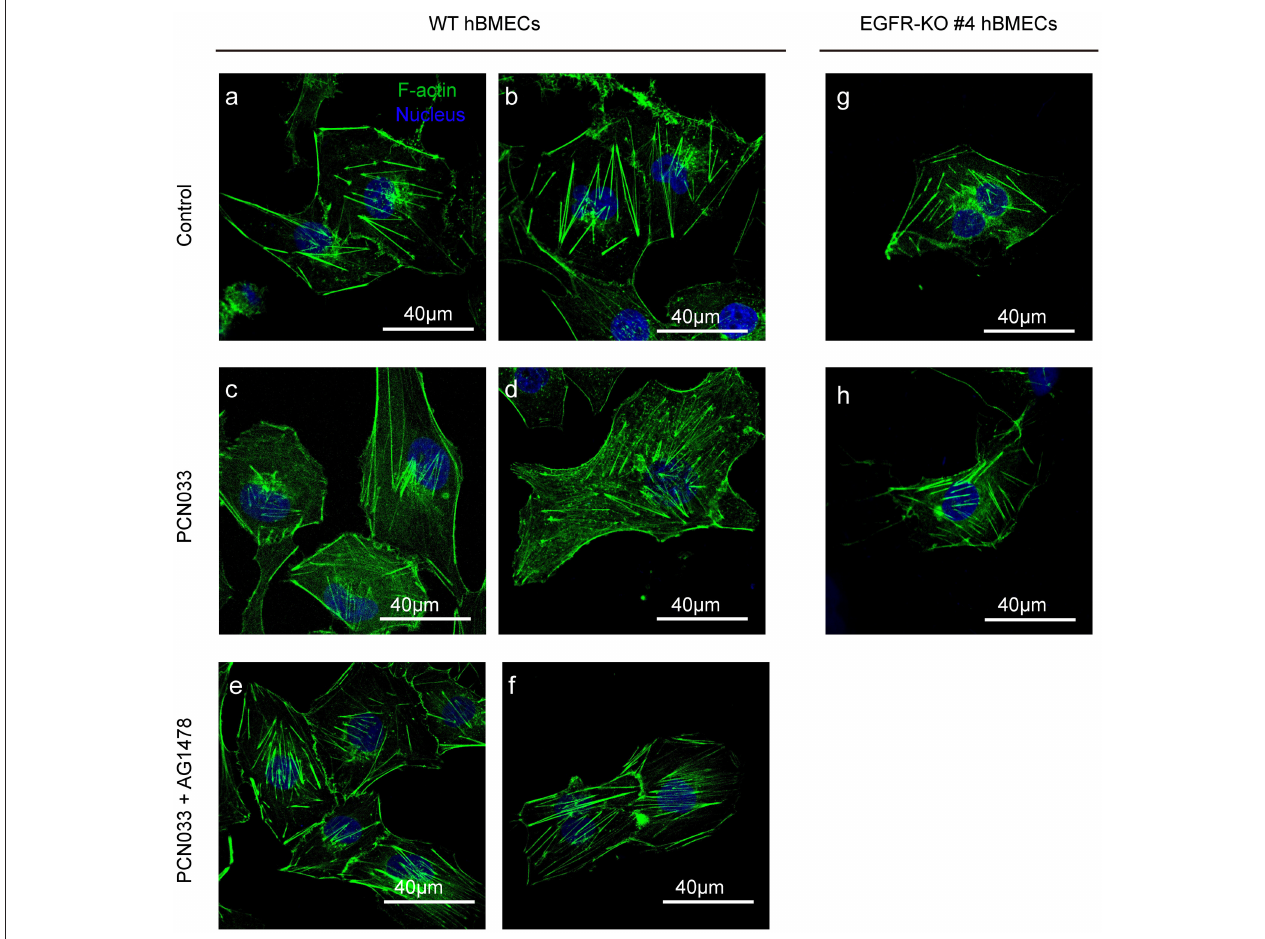
FIGURE 3 | EGFR activation assists with PCN033-induced cytoskeleton fiber breakdown. The wild-type hBMECs (a–f) and the EGFR-KO cells (clones #4, g,h ) were challenged with PCN033 with or without AG1478 (as described in Materials and Methods), and then subjected to confocal fluorescence microscopy. F-actin is labeled with actin-tracker green, and nuclei are stained with DAPI. The (a–f) were biological duplicates in each group, respectively.